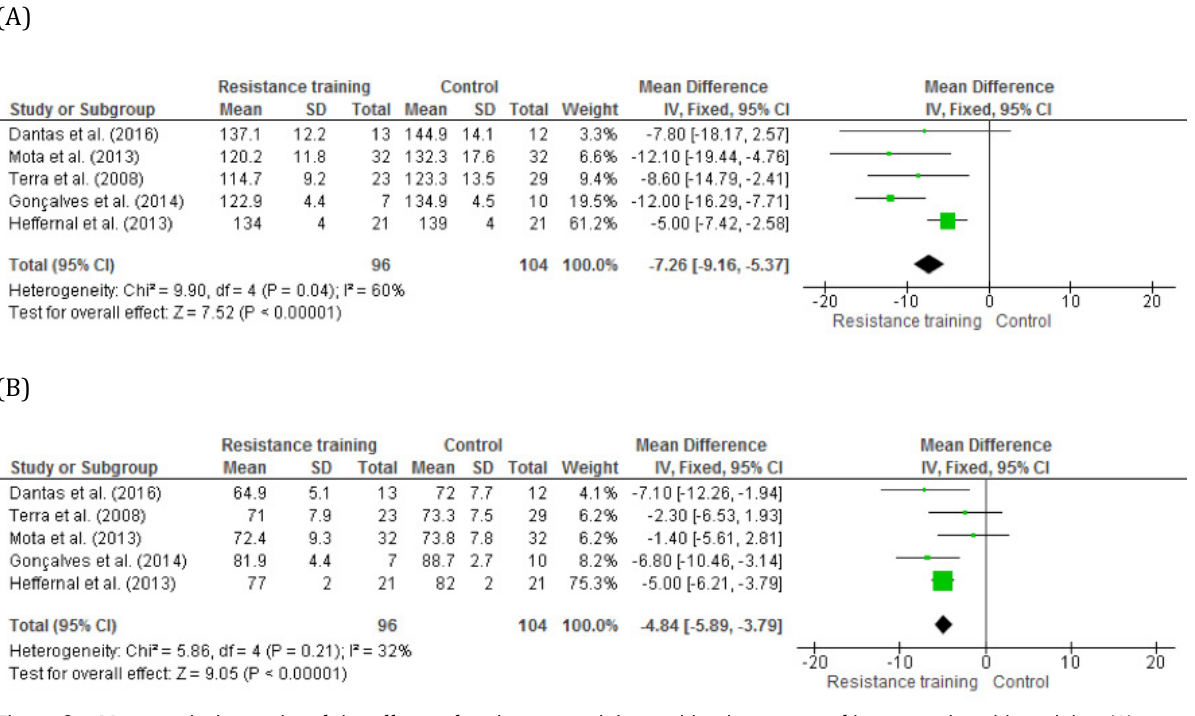
Figure 2 – Meta-analysis results of the effects of resistance training on blood pressure of hypertensive older adults: (A) systolic blood pressure (SBP); (B) diastolic blood pressure